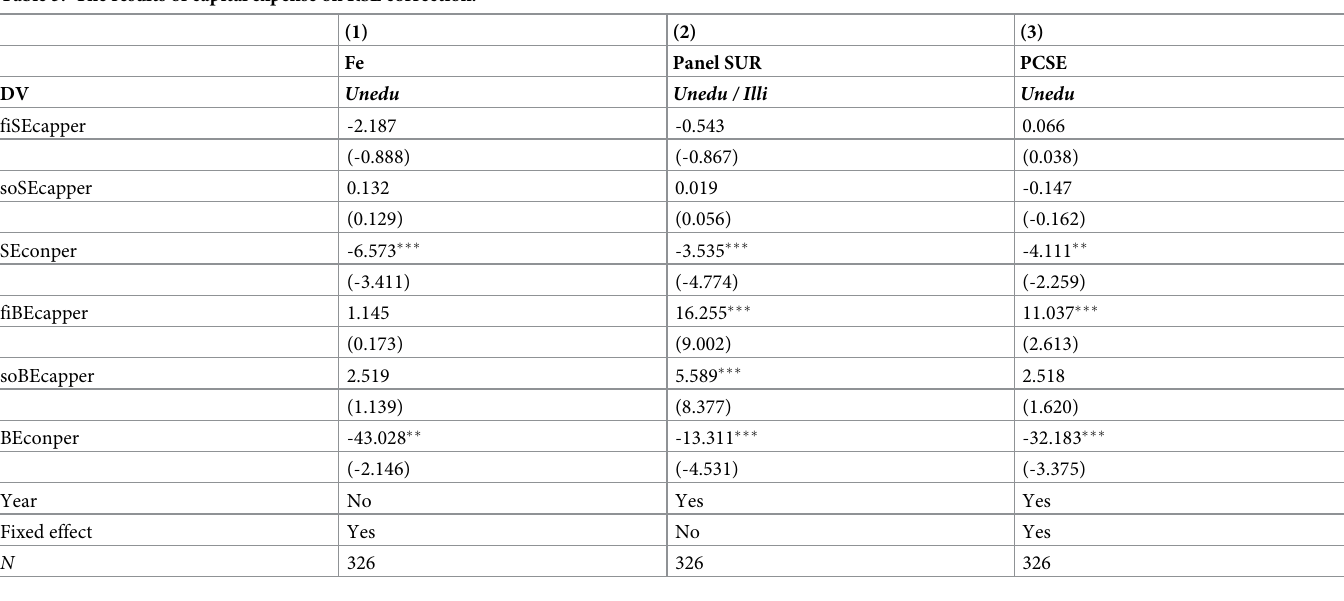
Table 3. The results of capital expense on RSE correction.